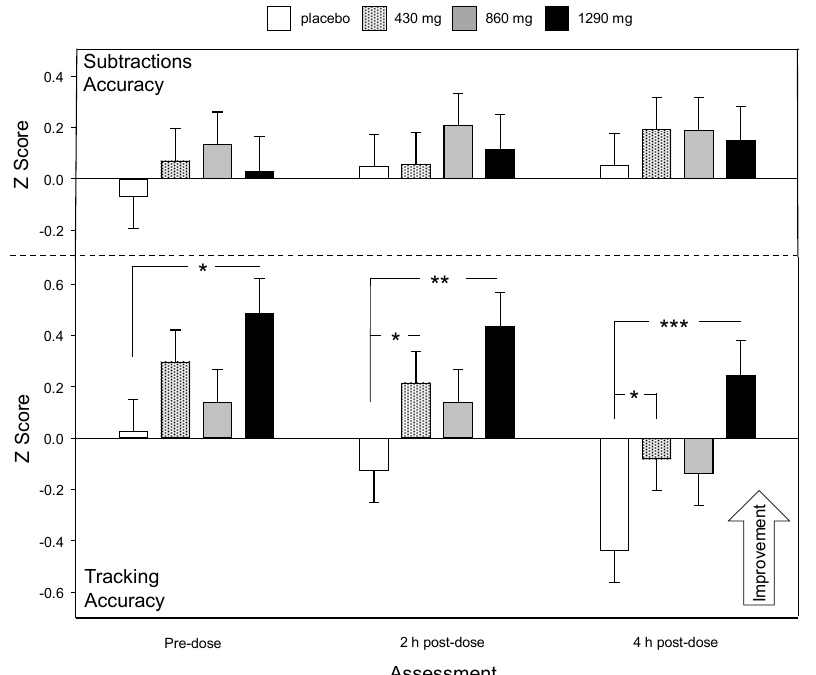
Figure 7. Chronic (Day 29) treatment related change in multitasking performance (accuracy of subtractions and tracking) during the OMS pre-dose and during the 2 h and 4 h post-dose assessments. Data are estimated means (plus SE) of Z score data, derived from the LMM analysis, using pretreatment (Day 1 pre-dose assessment) data and participant’s age as covariates. The Z scores are plotted with an increased score indicating improved performance. The top panels show subtraction accuracy (errors) the bottom panels show tracking accuracy data from a single LMM analysis. t, p < 0.1, *, p < 0.05; **, p < 0.01; ***, p < 0.001 in comparison to placebo.